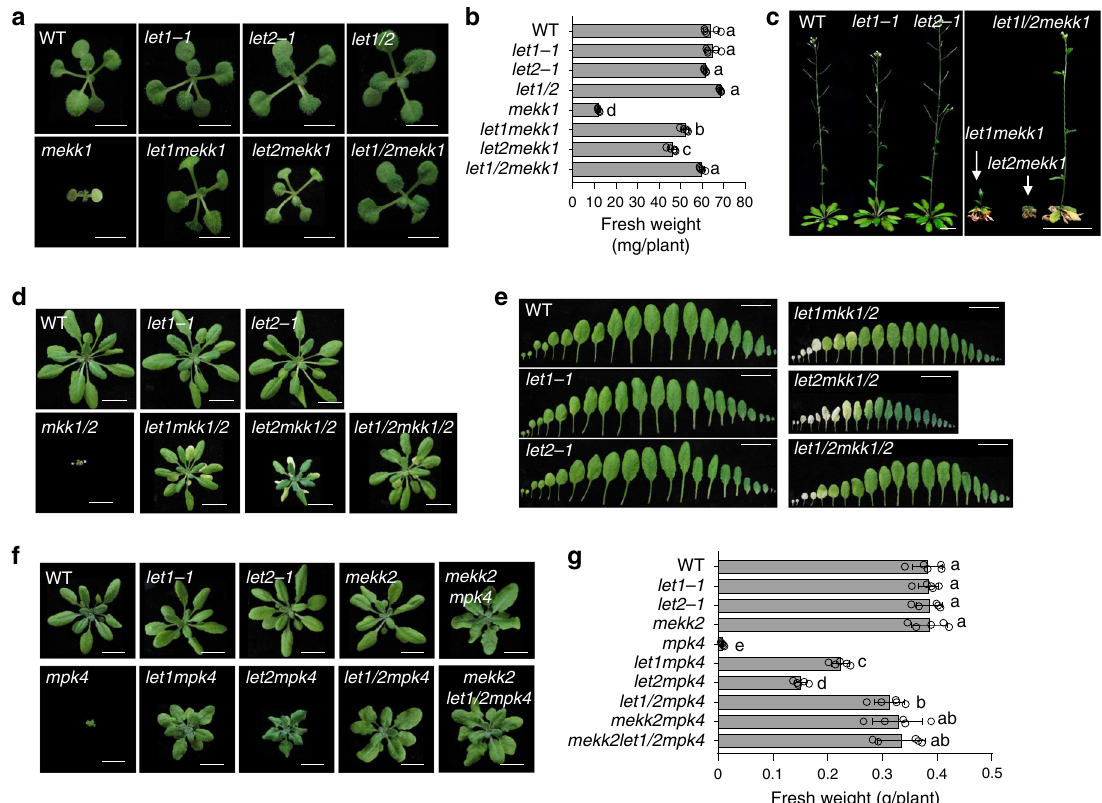
Fig. 2 LET1 and LET2/MDS1 function additively in regulating mekk1 , mkk1/2 , and mpk4 cell death. a – c LET1 and LET2/MDS1 function additively in regulating mekk1 cell death. a Two-week-old plants of different genotypes grown on ½MS plates are shown. Scale bar, 0.5 cm. b The fresh weight of the indicated plants in a . The data are shown as the mean ± SE ( n = 5). P = 1.00 × 10 − 13 (column 5 and 6), P = 1.00 × 10 − 13 (column 5 and 7), P = 1.00 × 10 − 13 (column 5 and 8), P = 1.53 × 10 − 5 (column 6 and 8), and P = 5.71 × 10 − 11 (column 7 and 8). The different letters indicate the signi fi cant difference determined by one-way ANOVA followed by the Tukey test ( P < 0.05). c Six-week-old soil-grown plants are shown. Scale bar, 1 cm (left panel) and 2 cm (right panel). d , e LET1 and LET2/MDS1 function additively in regulating mkk1/2 cell death. Four-week-old soil-grown plants ( d ) and leaves ( e ) are shown. Scale bar, 1 cm. The leaves from the individual plants were placed with the order of age (from oldest to youngest). f , g LET1 and LET2/MDS1 function additively in regulating mpk4 cell death. Four-week-old soil-grown plants ( f ) and their fresh weight ( g ) are shown. Scale bar, 1 cm. The data are shown as the mean ± SE ( n = 5) with one-way ANOVA followed by the Tukey test ( P < 0.05). P = 7.72 × 10 − 13 (column 5 and 6), P = 3.51 × 10 − 8 (column 5 and 7), P = 4.71 × 10 − 13 (column 5 and 8), P = 4.71 × 10 − 13 (column 5 and 9), and P = 4.71 × 10 − 13 (column 5 and 10). The above experiments were repeated three times with similar